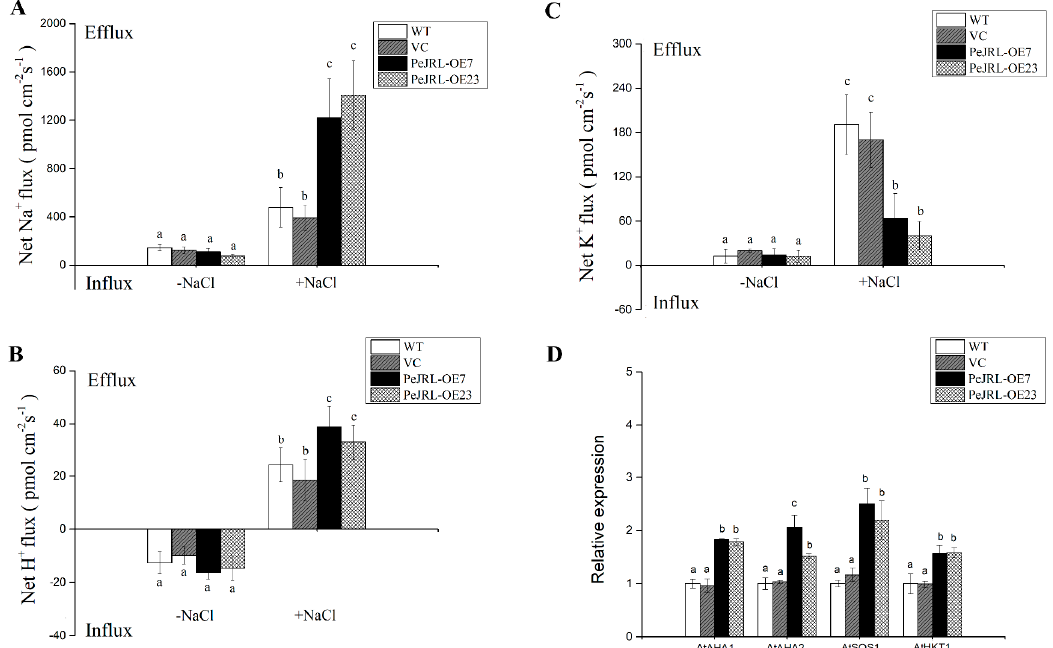
Figure 7. Effects of NaCl on Na + , K + , and H + fluxes and transcription of K + /Na + homeostasis genes in roots of wild-type (WT) Arabidopsis, vector control (VC), and PeJRL -transgenic lines (OE7 and OE23). Seven-day-old seedlings were treated without or with NaCl (125 mM) for 12 h. Steady-state flux profiles of Na + ( A ), H + ( B ), and K + ( C ) in roots of WT Arabidopsis, VC, and PeJRL -transgenic lines (PeJRL-OE7 and PeJRL-OE23) were measured at the apical zone (ca 200 µ m from the root apex) for 10 min. Mean fluxes of no-salt control ( − NaCl) and salt-stressed roots (+NaCl) are shown. ( D ) Relative expression levels of AHA1 , AHA2 , SOS1 , and HKT1 in WT Arabidopsis, VC, and PeJRL -transgenic lines (OE7 and OE23) under NaCl treatment. Transcription of AHA1 , AHA2 , SOS1 , and HKT1 was detected with RT-qPCR. The Arabidopsis AtACTIN2 was used as the internal control. Primers designed to target AtAHA1 , AtAHA2 , AtSOS1 , and AtHKT1 , and AtACTIN2 genes are shown in Supplementary Materials Table S1. Each column corresponds to the mean of three ( D ) to seven (A – C) independent plants, and bars represent the standard error of the mean. For each tested gene, columns labelled with different letters (a–c) denote significant difference between WT, VC, and transgenic lines at p < 0.05.